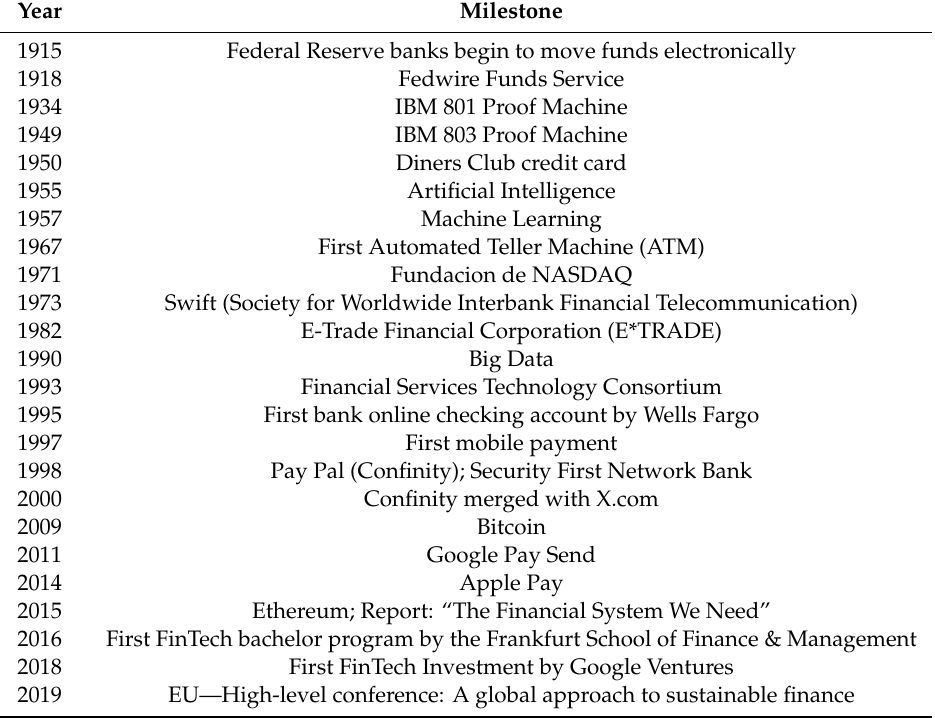
Table 1. Evolution of financial technology.